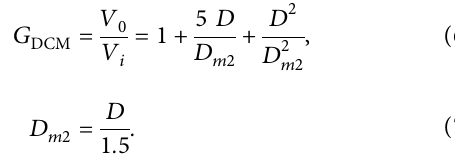
Figure 6. It is noted that all the diodes are in reverse biased condition, and the stored energy in capacitor C charged to the load R